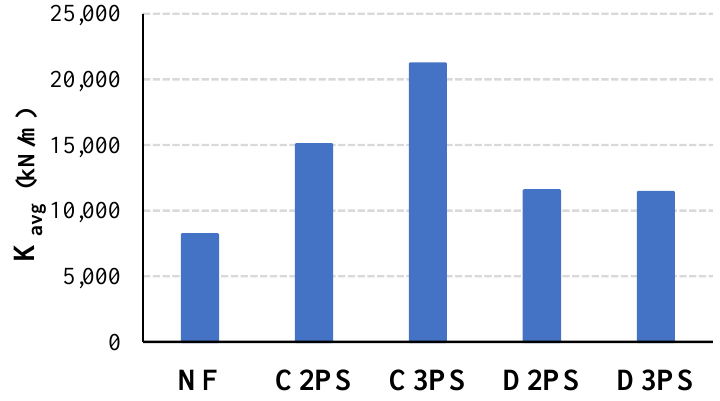
Figure 10. Initial and average stiffness for tested specimens.